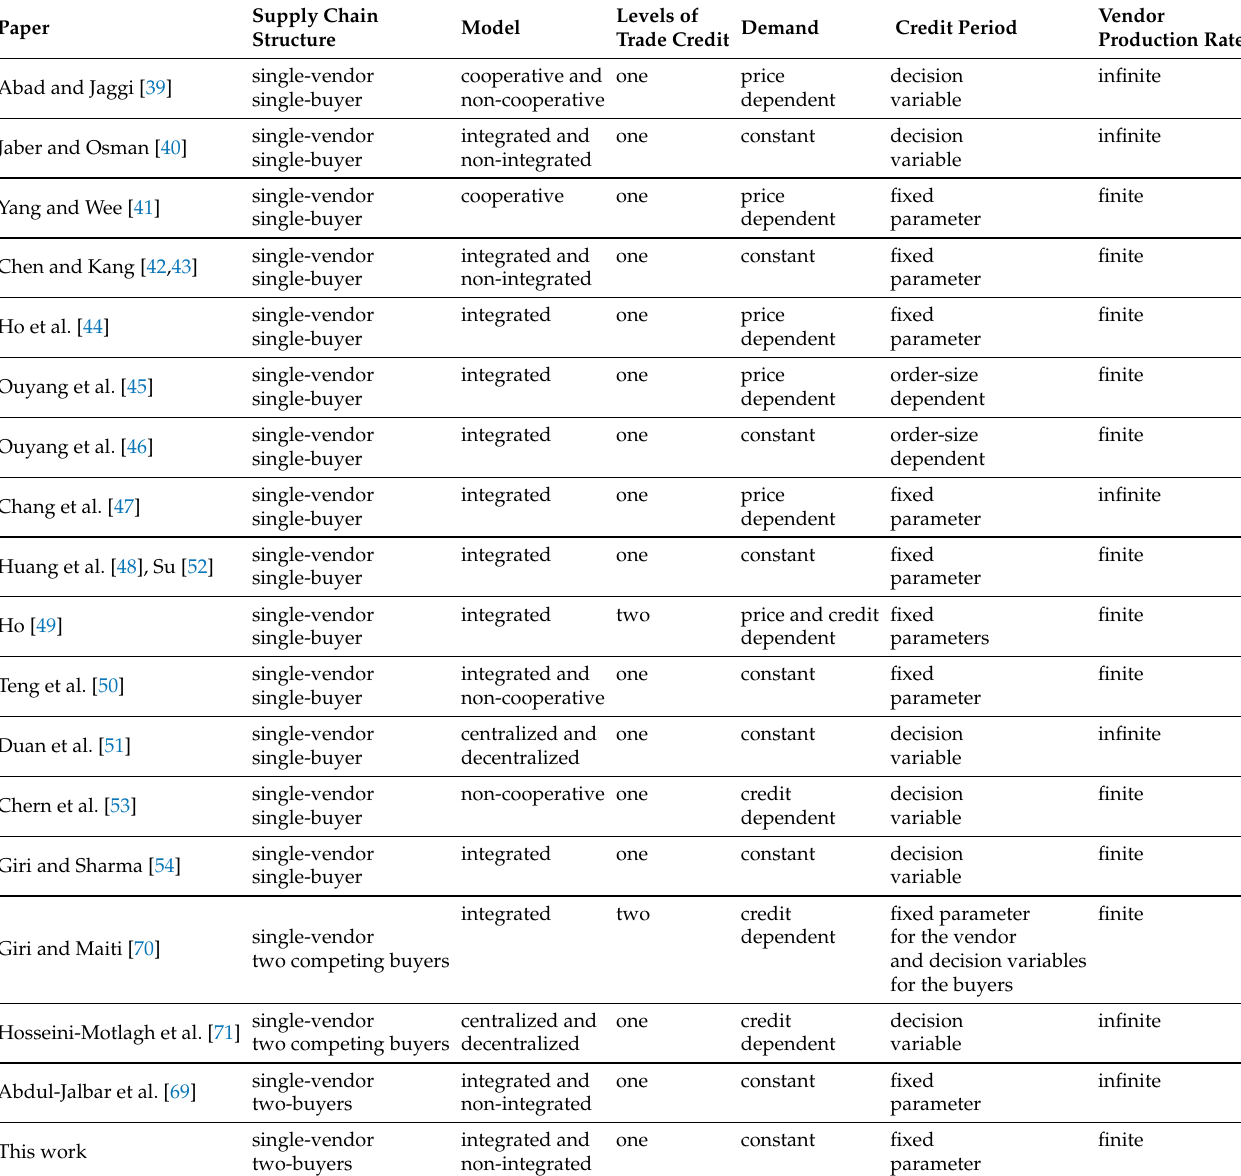
Table 1. Summary of works related to trade credit in two-echelon supply